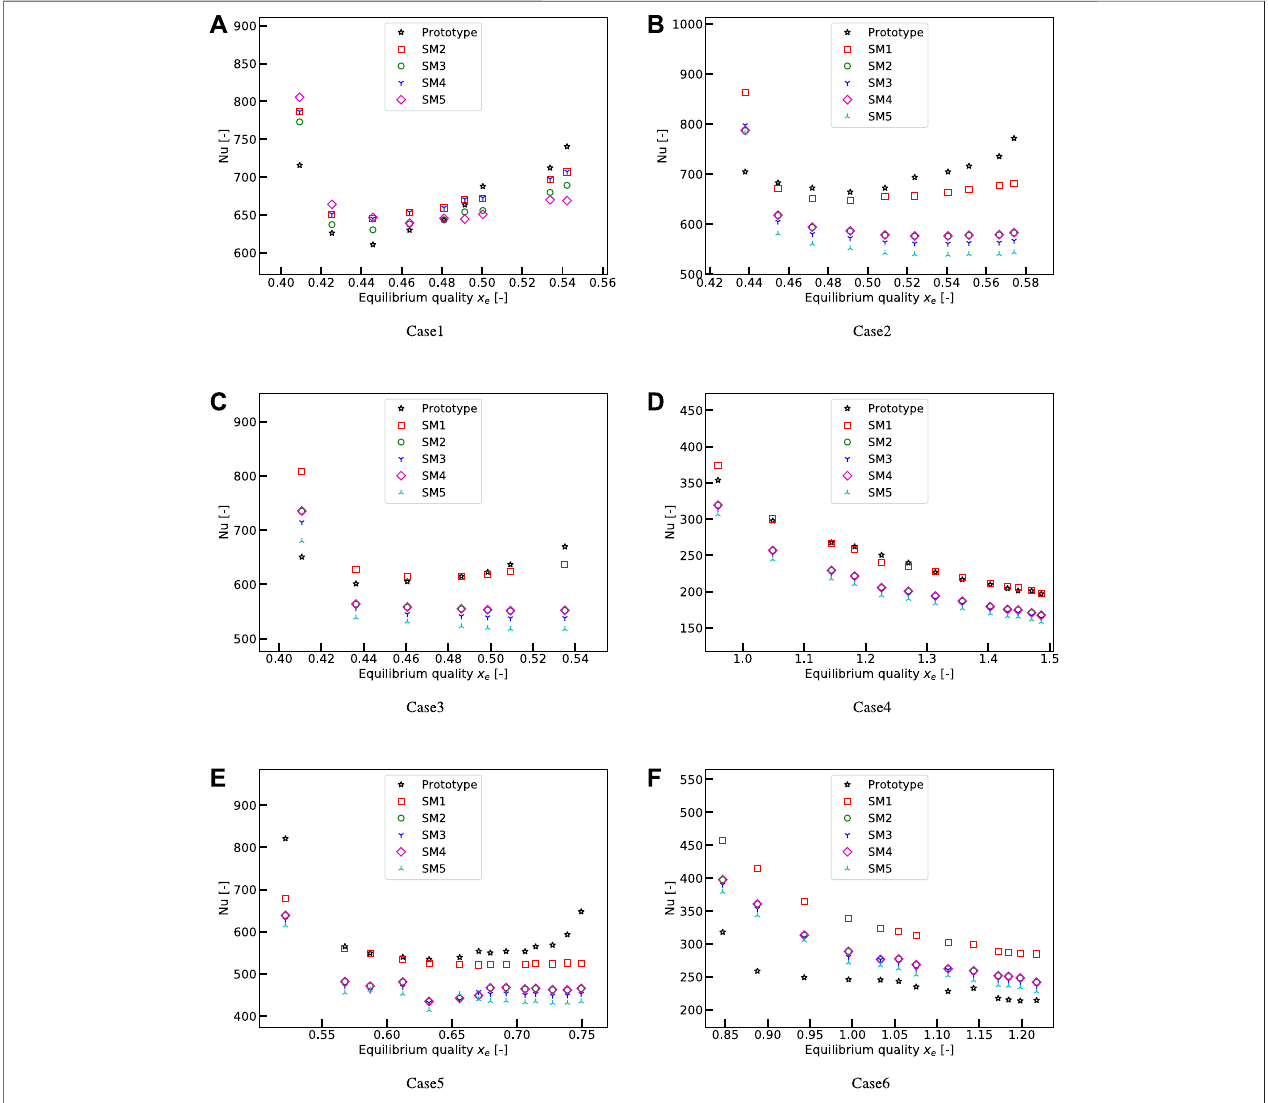
FIGURE 6 | Assessments of the optimized scaling methods with Prototype data from Bennett et al. (1968).